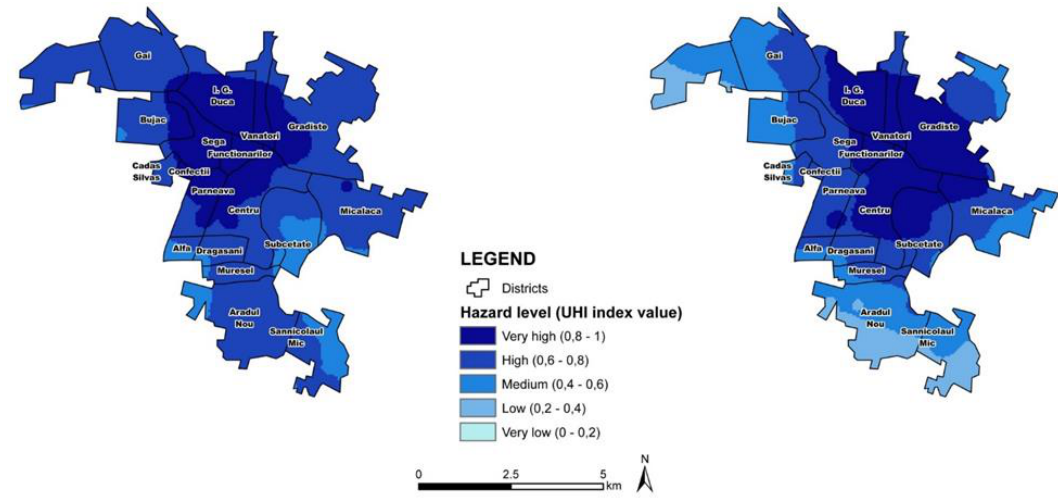
Figure 11. Heat wave hazard in the municipality of Arad (Romania) for day (left) and night time (right) [50].